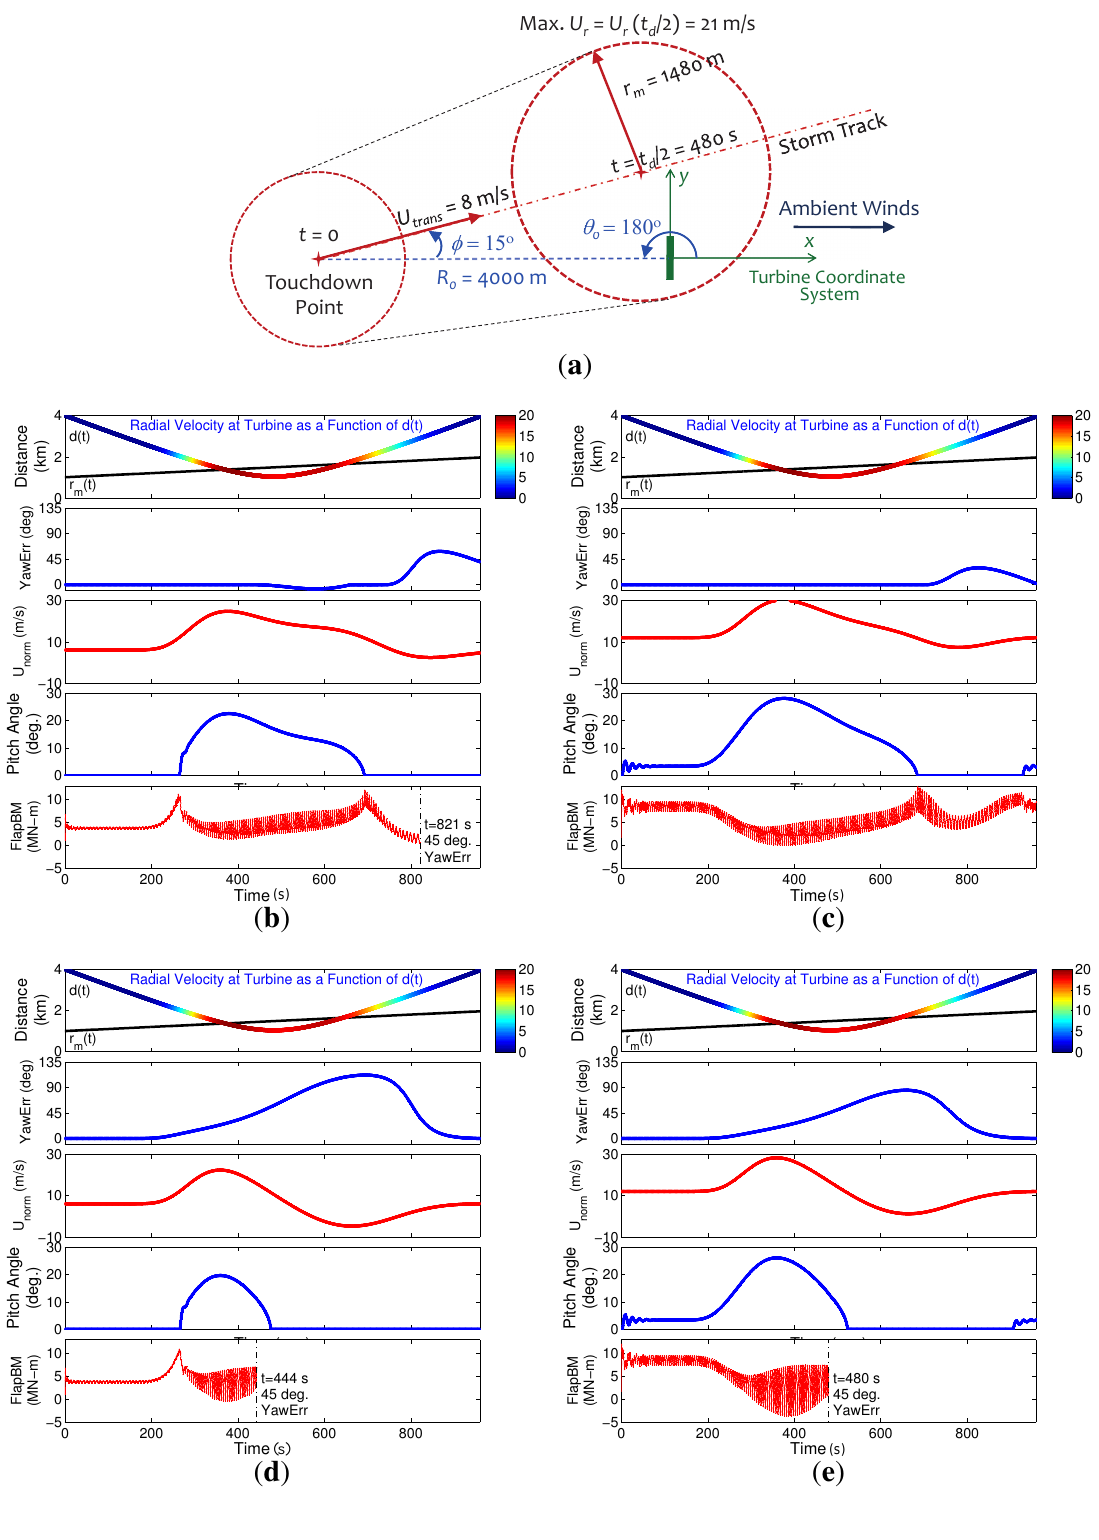
Figure 8. Simulation of wind fields and turbine loads for the JAWS “Average” case with R = 4 km; θ = 180 degree; φ = 15 degree. Note that d ( t ) = distance from downburst to 0 0 ( t ) = radius to maximum winds; U turbine (see Equation (7)); r m the rotor plane; P itch Angle = blade pitch angle; F lapBM = flapwise bending moment at blade root. ( a ) Plan view showing storm track and turbine; ( b ) U yaw control; ( c ) U = 12 m/s; with yaw control; ( d ) U amb ( e ) U = 12 m/s; no yaw amb